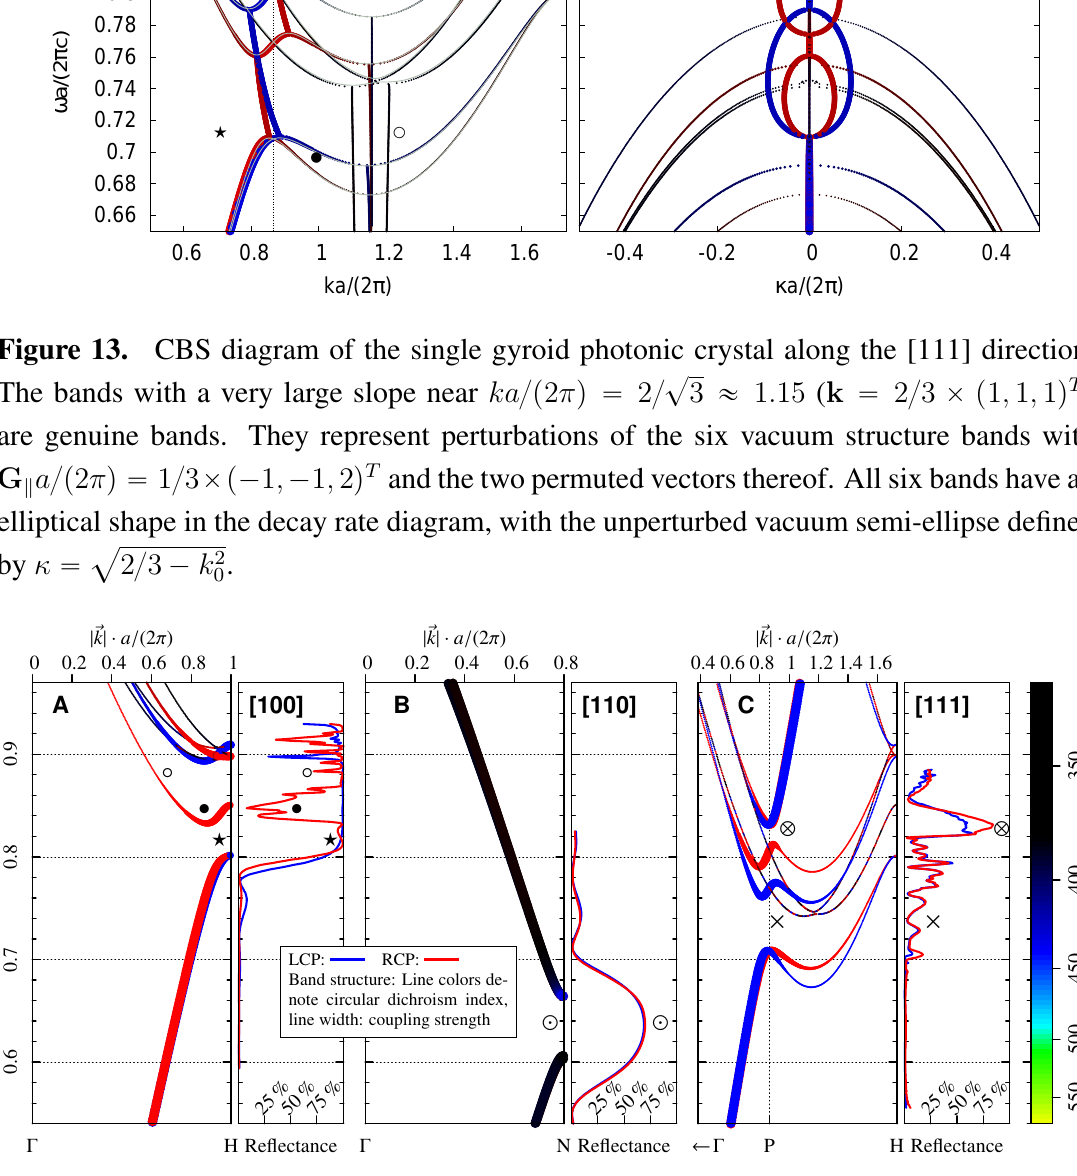
Figure 14. Direction dependence of the circular dichroism of the single gyroid structure. Circular dichroism along different crystallographic directions is quantified by the bulk band structure (left parts, coloring encodes dichroism index and line width coupling strength as defined in [5]; capital letters at the bottom denote boundaries of the Brillouin zone at high-symmetry points [53]) and by FDTD simulations of the reflectance (right parts, averaged over finite sheets of gyroid material of thickness 5 . 5 ¨ ¨ ¨ 6 . 1 ˆ a and terminations z “ 1 { 30 , 4 { 30 ): ( A ) [100] direction, ( B ) [110] direction, ( C ) [111] direction. The 0 single gyroid is modelled by the nodal approximation (Equation (34)) with t “ ´ 0 . 90 , corresponding to a volume fraction of solid chitin of φ « 20 %; the dielectric constant is ε “ 2 . 4